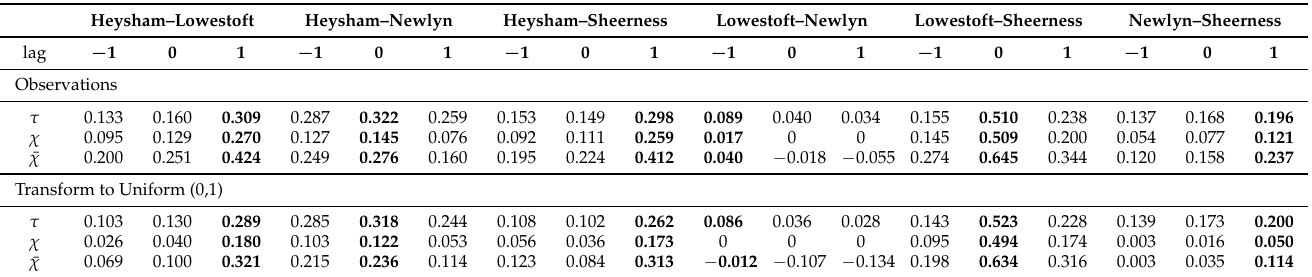
Table 5. Kendall’s τ , χ and ¯ χ measures of dependence for daily maximum skew surge observations at pairs of sites. We show the dependence over lags − 1 (LHS site is 1 day behind RHS), 0 and 1 (LHS site is 1 day ahead of RHS); in bold we show the largest dependence over these lags. χ and ¯ χ are measures of extremal dependence for exceedances of the 0.95